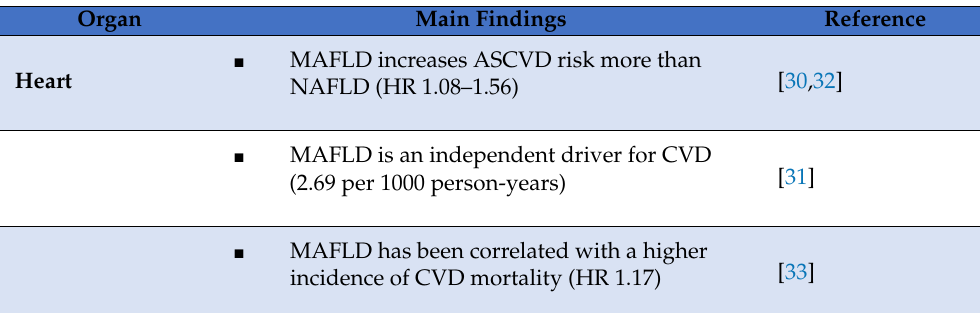
Table 1. Major findings on the relationship between MAFLD and heart. Main